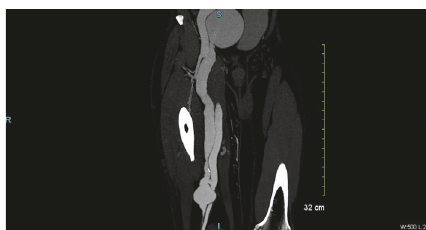
Figure 2: CT angiogram showing a superficial femoral arteriove- nous fistula with arteriomegaly of the right external iliac artery.